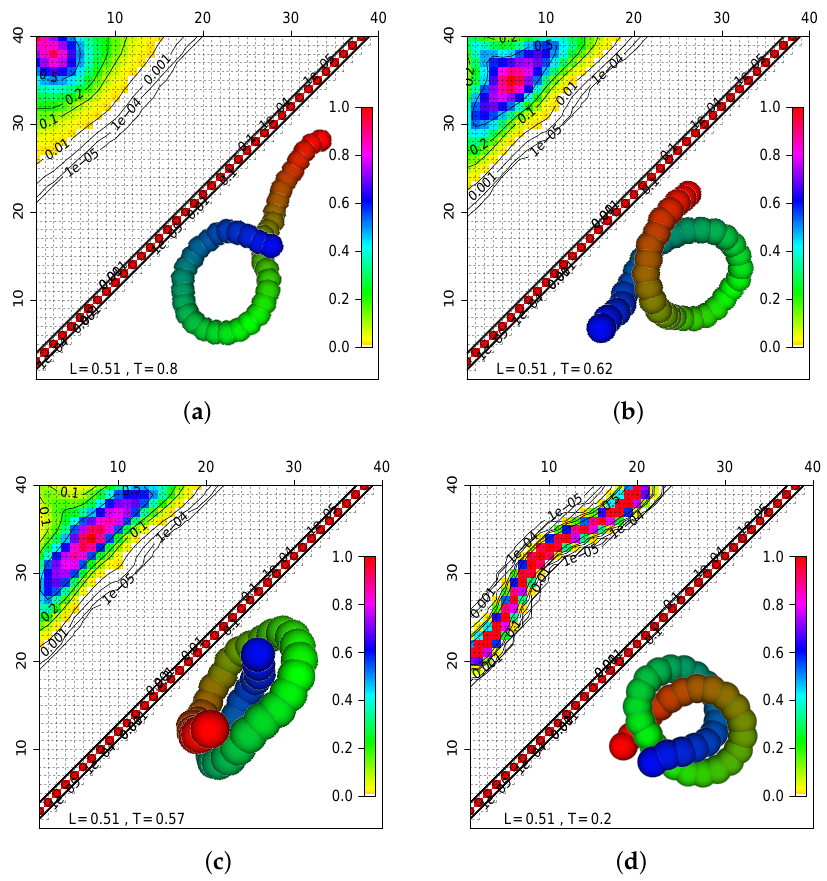
Figure 9. Contact matrices for the chain of length N = 40, bond length L = 0.51 and for the temperatures T = 0.8 in ( a ); T = 0.62 in ( b ); T = 0.57 in ( c ) and T = 0.2 in ( d ). The snapshots visualize the configurations giving rise to the contact